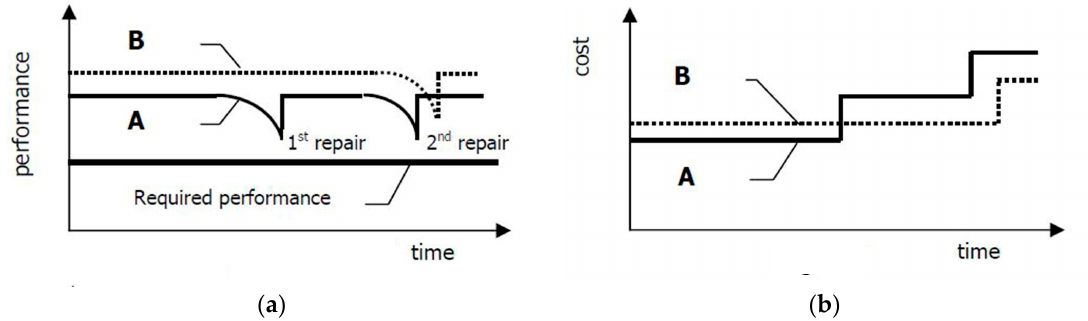
Figure 8. Performance ( a ) and cost ( b ) over time for low (A) and high (B) structures. Direct repair costs included. Interest and inflation not considered Error! Reference source not found. .